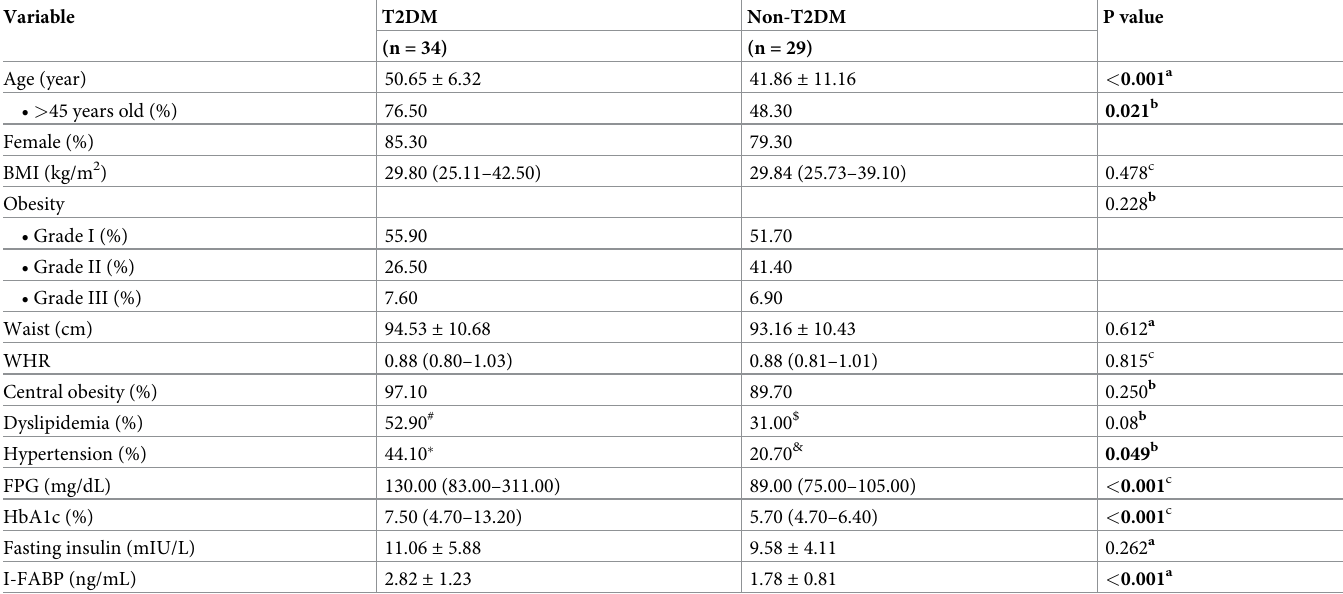
Table 1. Subject